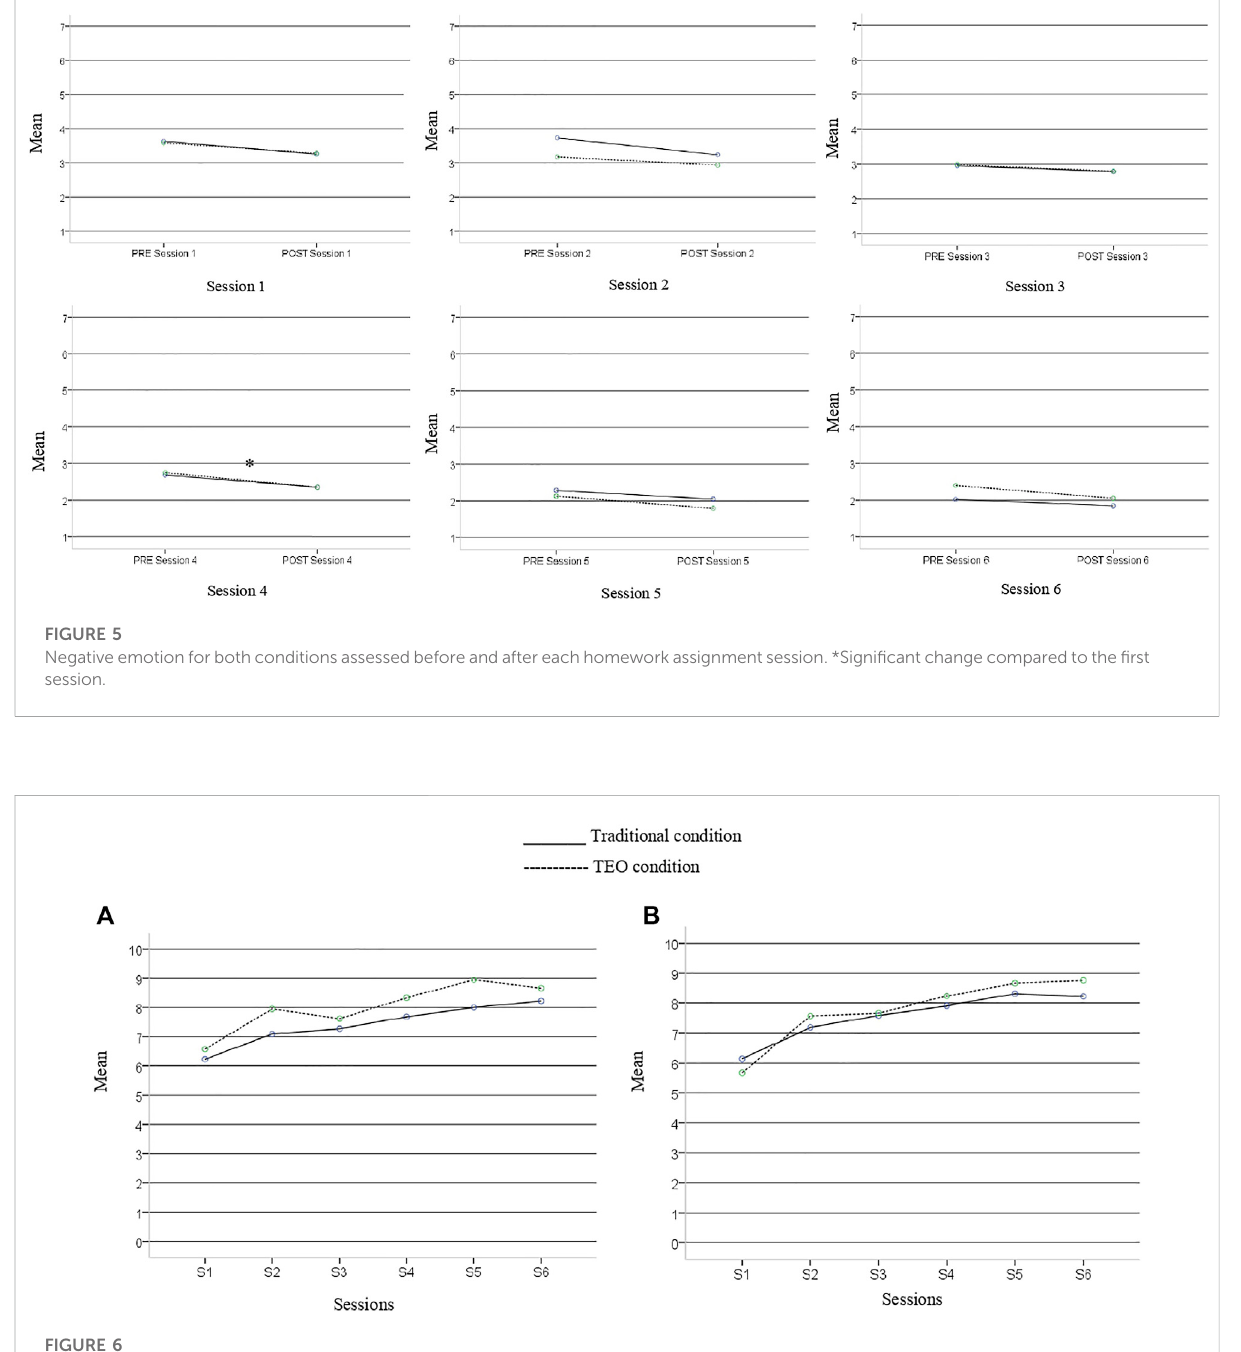
Frontiers in Virtual